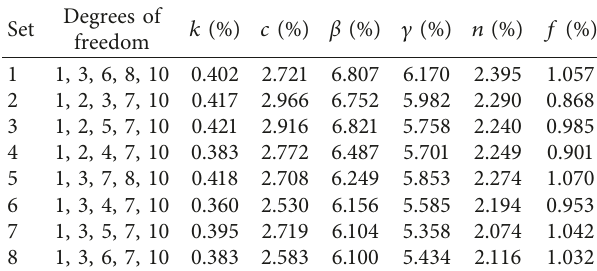
Table 10: Identified errors of several sets of five measured